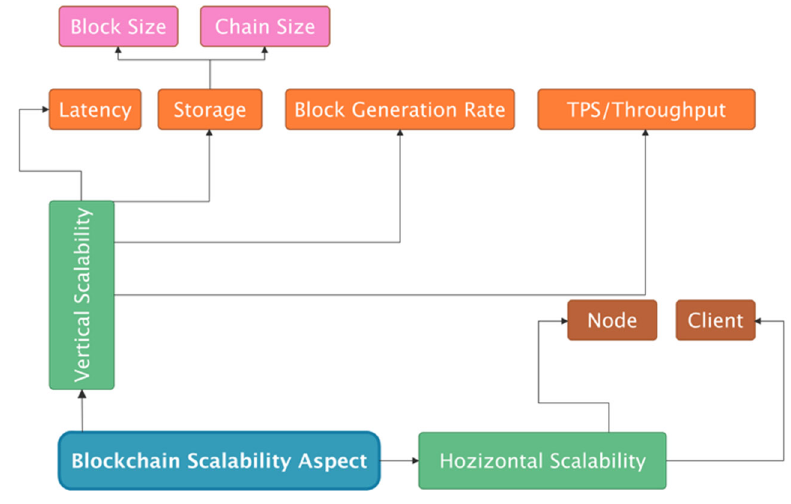
Figure 3. Blockchain scalability aspect .